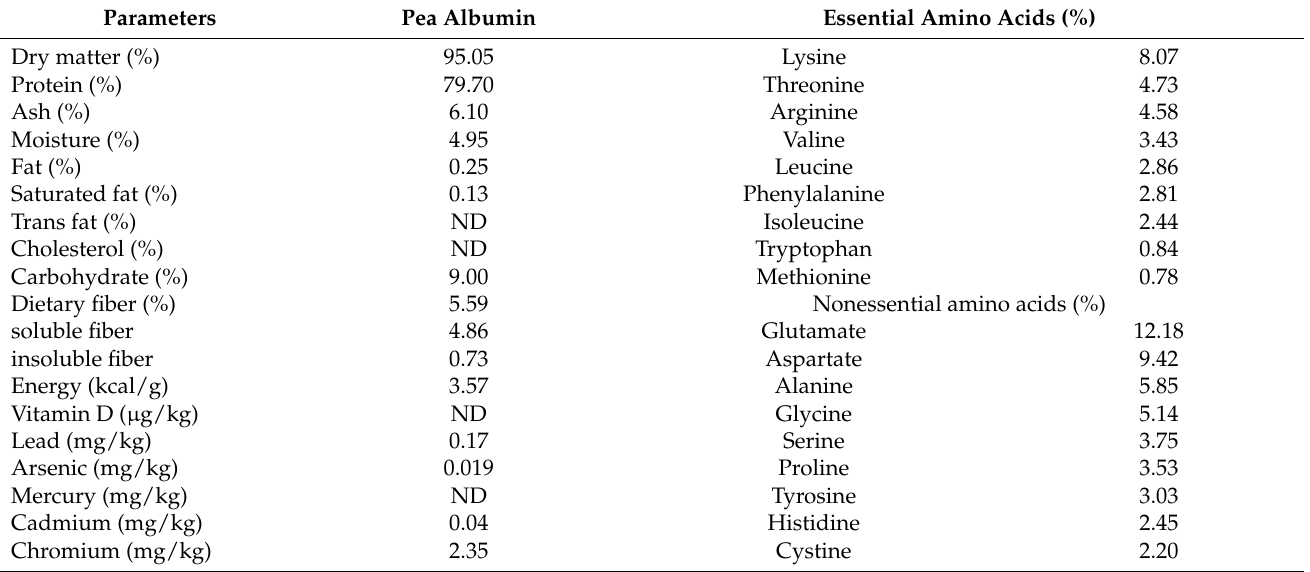
Table 1. Composition and amino acid profile of pea